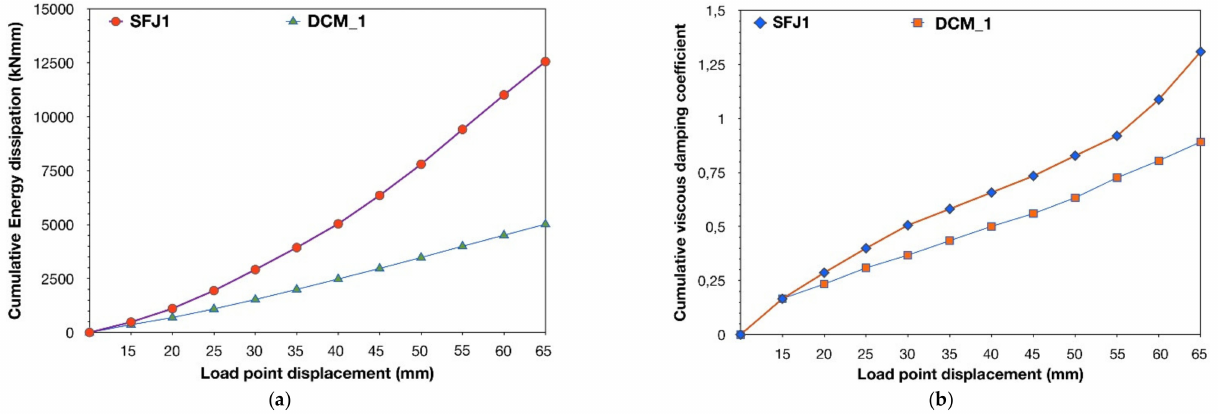
Figure 16. Plots of ( a ) cumulative energy dissipation versus load point displacement and ( b ) cumulative viscous damping coefficient versus load point displacement of subassemblages SFJ1 and